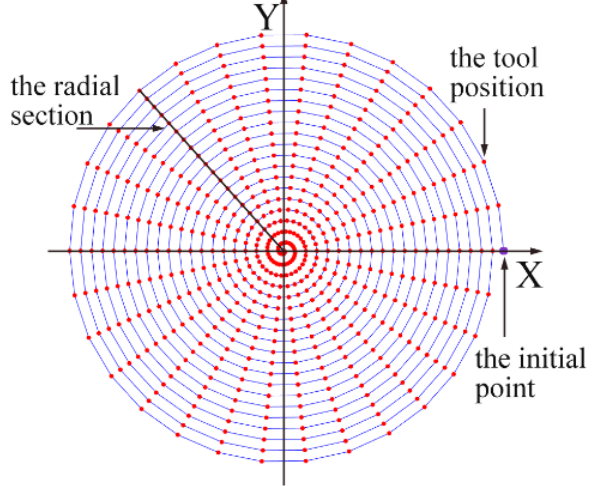
Figure 4. The spiral tool trajectory and the distributed tool positions in the modeling, where the red points denote different positions of the tool in the cutting process.